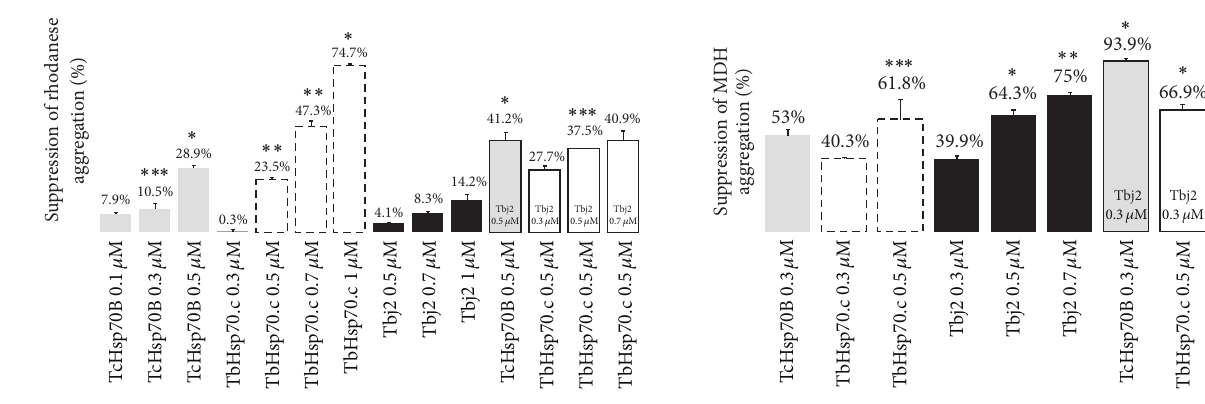
Figure 3: Suppression of rhodanese aggregation by TbHsp70.c, TcHsp70B, and Tbj2. The rhodanese concentration was maintained at 1.5 𝜇 M, the aggregation of denatured rhodanese was measured at 300nm over 40 min and the concentrations of all components are given in the figure. TcHsp70B, TbHsp70.c, and Tbj2 suppress aggregation of denatured rhodanese in a dose-dependent manner. Each assay was conducted in triplicate and three independent experiments on independent batches of protein were conducted and the data shown represents that of a typical experiment. The bars represent standard deviations. ∗ 𝑃 < 0.001 , ∗∗ 𝑃 < 0.01 , and ∗∗∗ 𝑃 ≤ 0.05 .